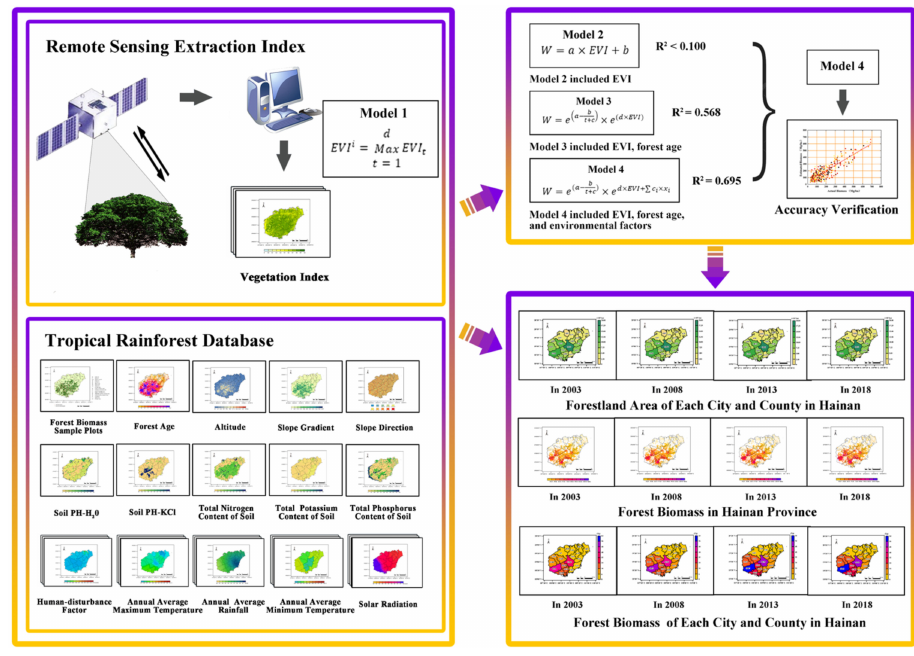
Figure 1. Tropical rainforest biomass estimation with remote sensing.